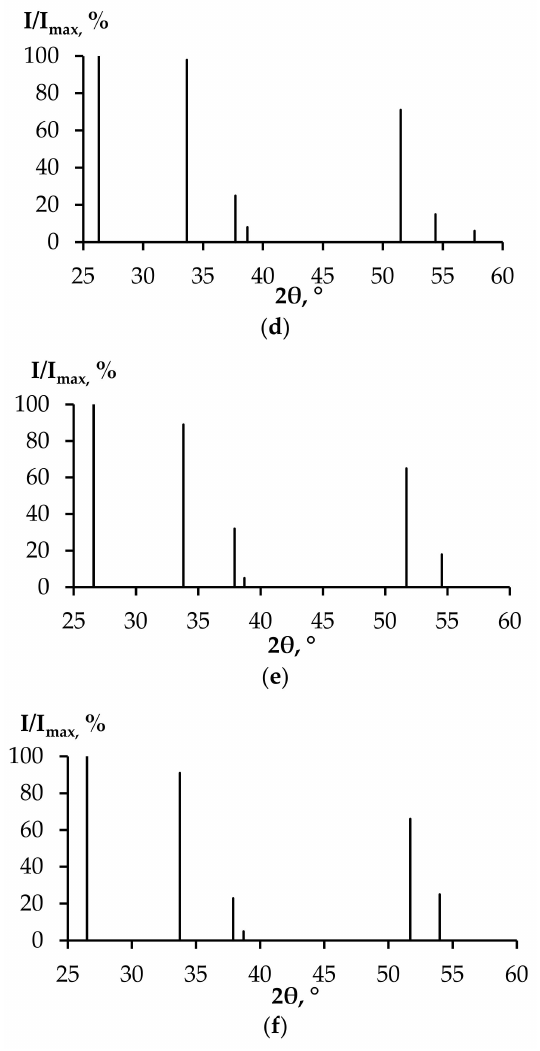
Figure 10. XRD patterns (after thermal treatment at 600 ◦ C) showing the intensity of diffracted X-rays in planes as a function of 2 θ for three samples: ( a , f ) 10SiO 2 –85SnO 2 –5In 2 O 3 ; ( b , e ) 10SiO 2 – 80SnO 2 –10In 2 O 3 ; ( c , d ) 10SiO 2 –75SnO 2 –15In 2 O 3 (the Miller indices (hkl) are also shown beside the peaks).